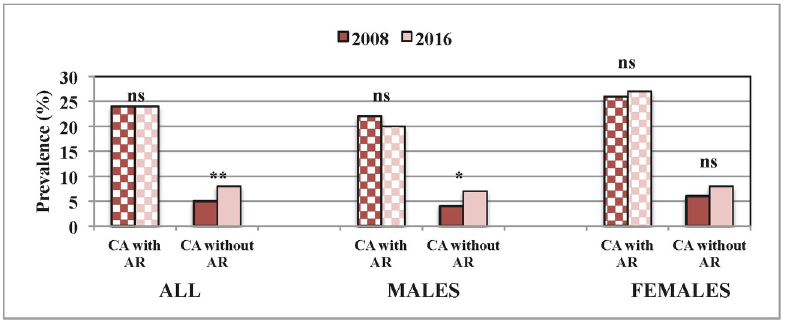
Fig 1. Current asthma in relation to allergic rhinitis and gender. The prevalence of current asthma (CA) among subjects with and without allergic rhinitis (AR) in 2008 and 2016, stratified for gender. � p < 0.05, �� p < 0.01, ��� p < 0.001, ns = not